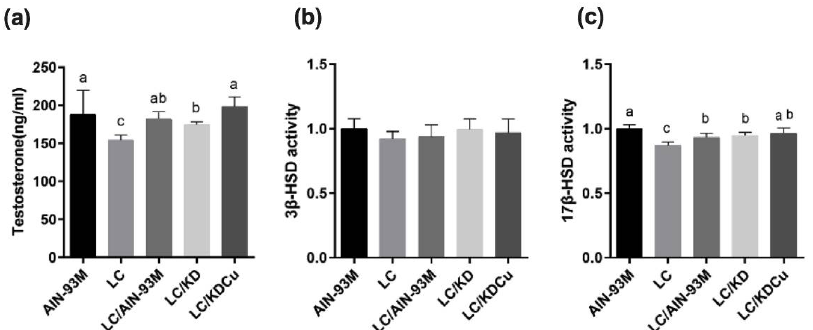
Figure 5. Effects of the low carbohydrate diet and curcumin on testicular ( a ) testosterone, ( b ) 3 β -HSD, ( c ) 17 β -HSD levels in male mice. Data are expressed as means ± SD. n = 5 per group. Bars (a, b, c) with different letters indicate that values are significantly different. (One-way ANOVA, Duncan’s test, p < 0.05). AIN-93M: AIN-93M diet; LC: low carbohydrate diet; LC/AIN-93M: low carbohydrate diet changed to AIN-93M diet; LC/KD: low carbohydrate diet changed to ketogenic diet; LC/KDCu: low carbohydrate diet changed to ketogenic diet and curcumin.